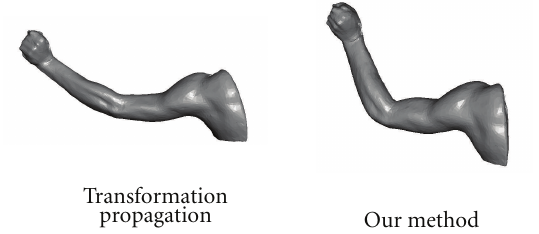
Figure 12: Comparison with the transformation propagation approach [16]. Our method produces a more realistic result because the elbow bends sharply and the biceps bulges naturally. In contrast, the transformation propagation method deforms the model smoothly.